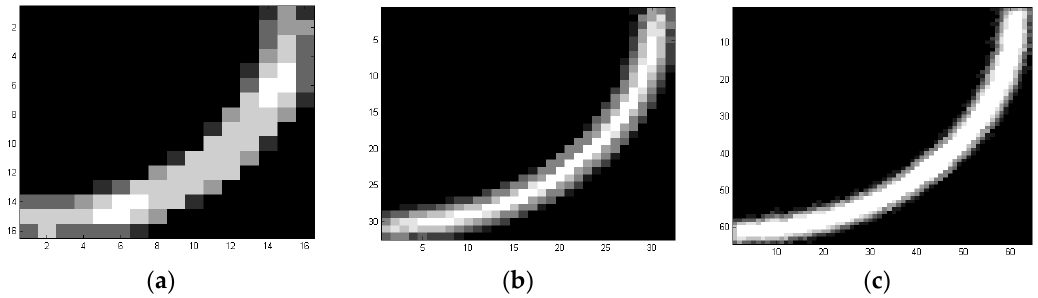
Figure 14. How accuracy of models can be affected by segmentation size. ( a ) 16 divisions, ( b ) 32 divisions, ( c ) 64 divisions.